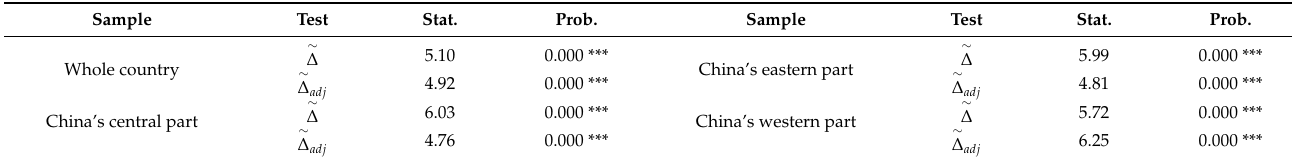
Table 3. Results of slope heterogeneity.